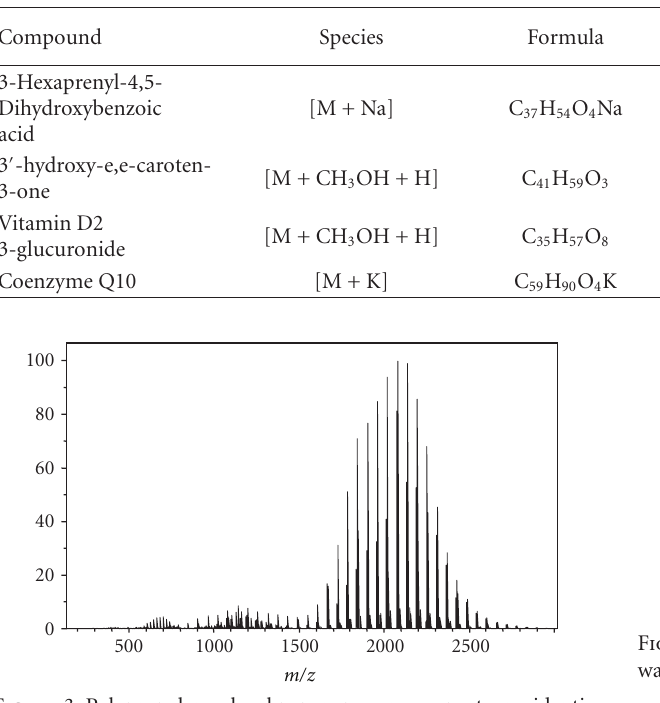
Figure 3: Polypropylene glycol paper spray mass spectrum; identi- fications of oligomers as given in the literature [2].